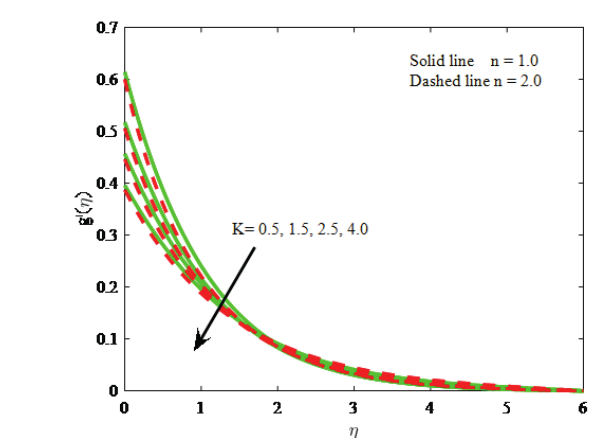
Fig. 6: Impact of K on micro-rotation